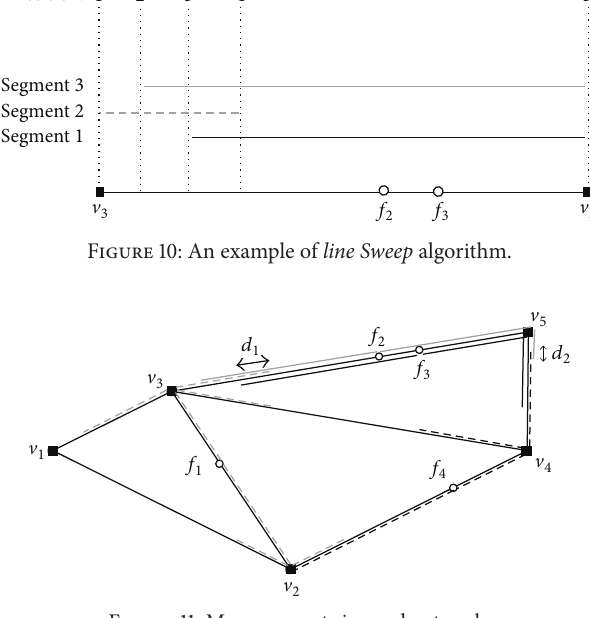
Figure 11: Max-segments in road network.